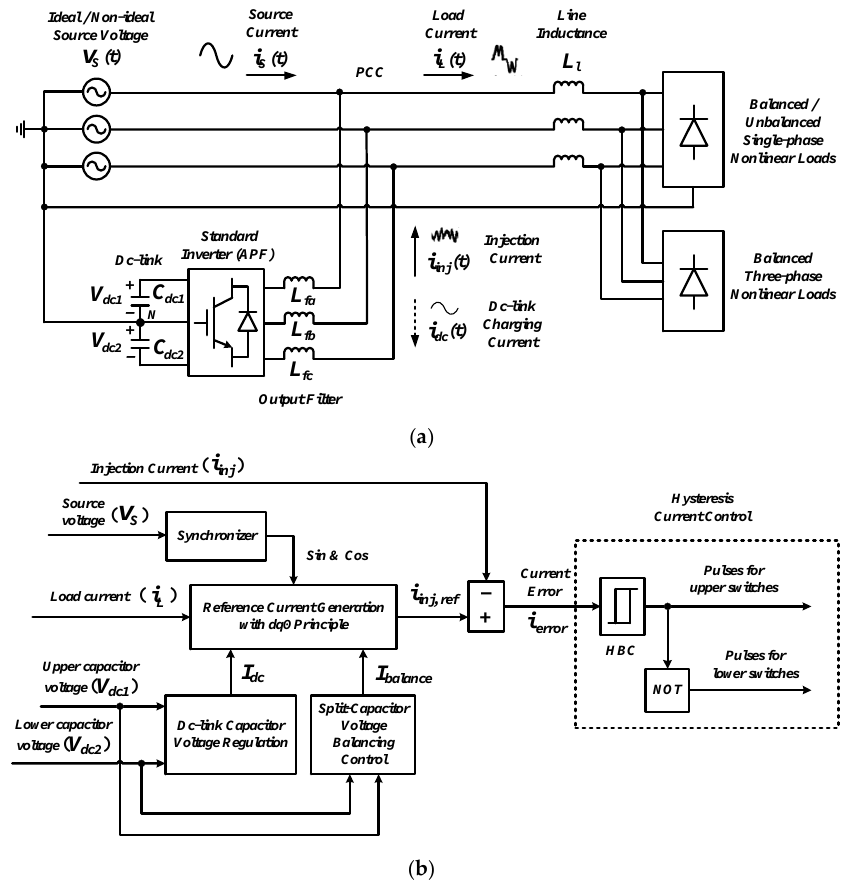
Figure 1. Three-phase three-leg four-wire shunt active power filter (SAPF) with two split dc-link capacitors: ( a ) power circuit arrangement, and ( b ) overall control structure.